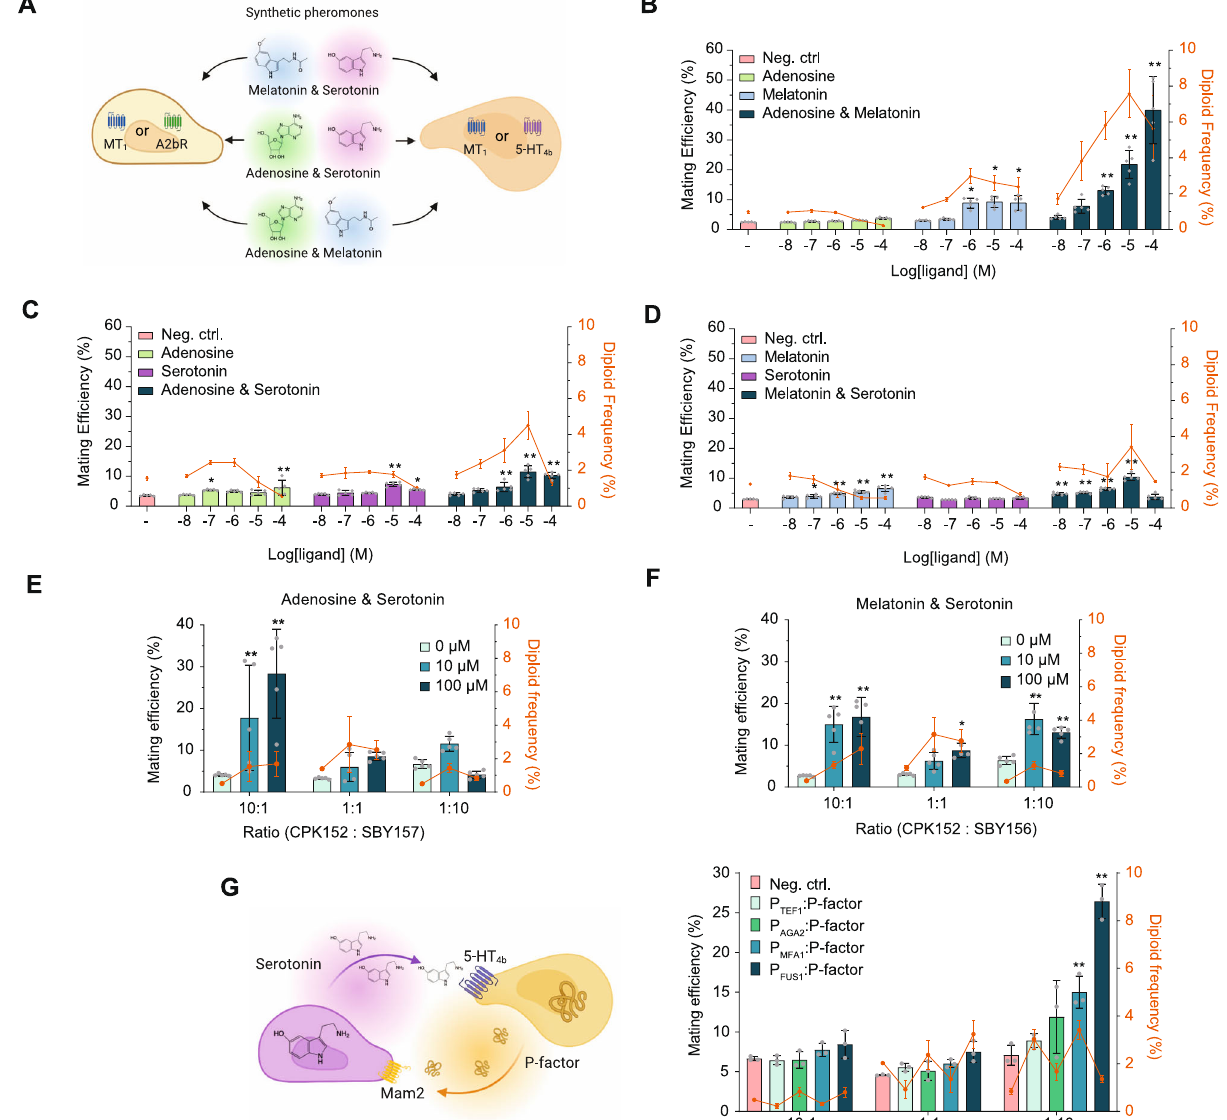
Fig. 5 | Heterologous GPCRs support full synthetic and autonomous yeast mating. A Individual or combined synthetic pheromone (cognate ligand) supple- mentation and biosensing of adenosine (A2bR), melatonin (MT 1 ), and serotonin